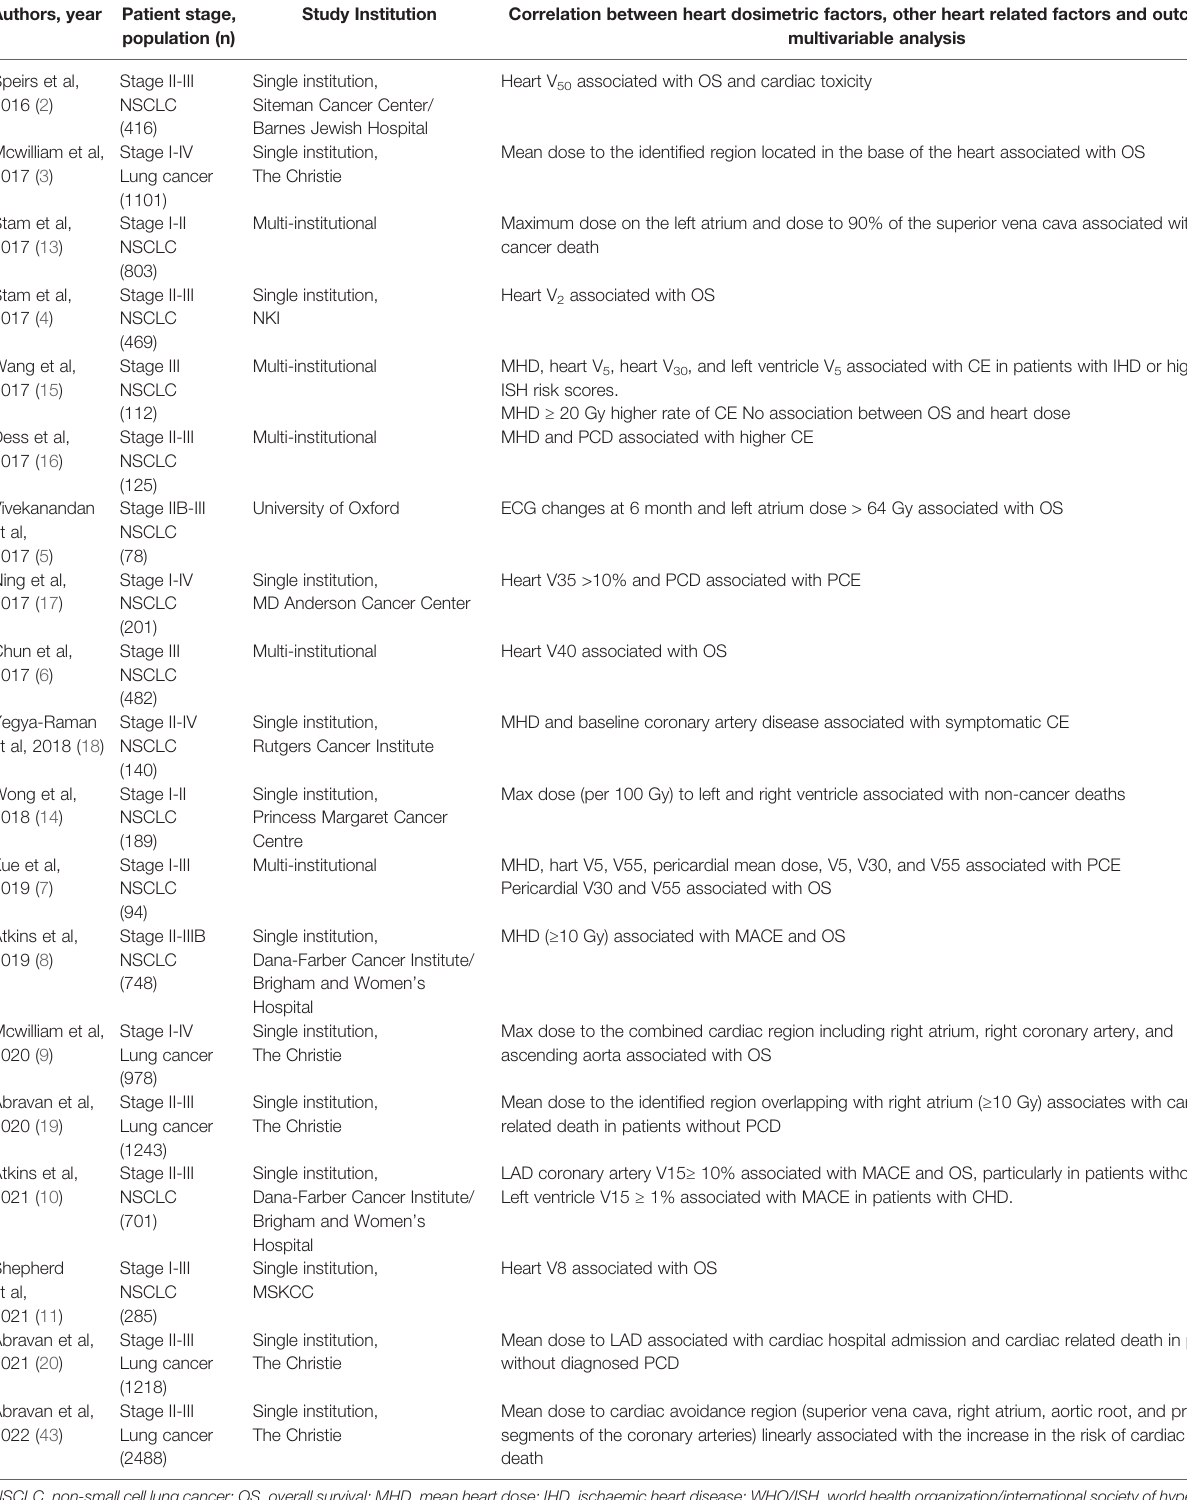
TABLE 1 | Summarizing RWD studies suggesting associations between heart dosimetric factors and outcome of patients with lung cancer in multivariable models. Authors, year Patient stage, population